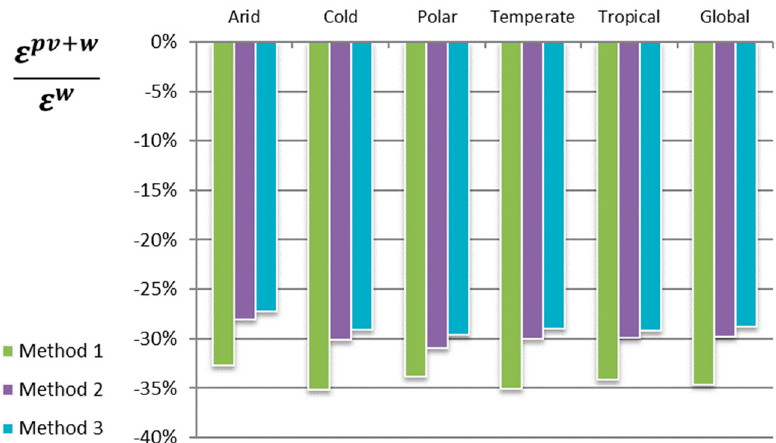
Figure 12. Improvement of the matching factor: ε pv + w (hybrid) over ε pv (solar PV) facilities.